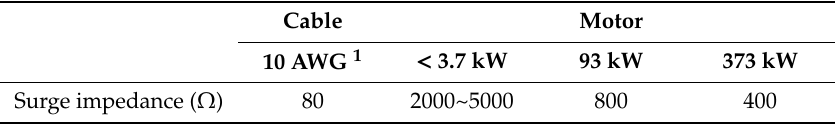
Table 3. Typical surge impedance of motor and